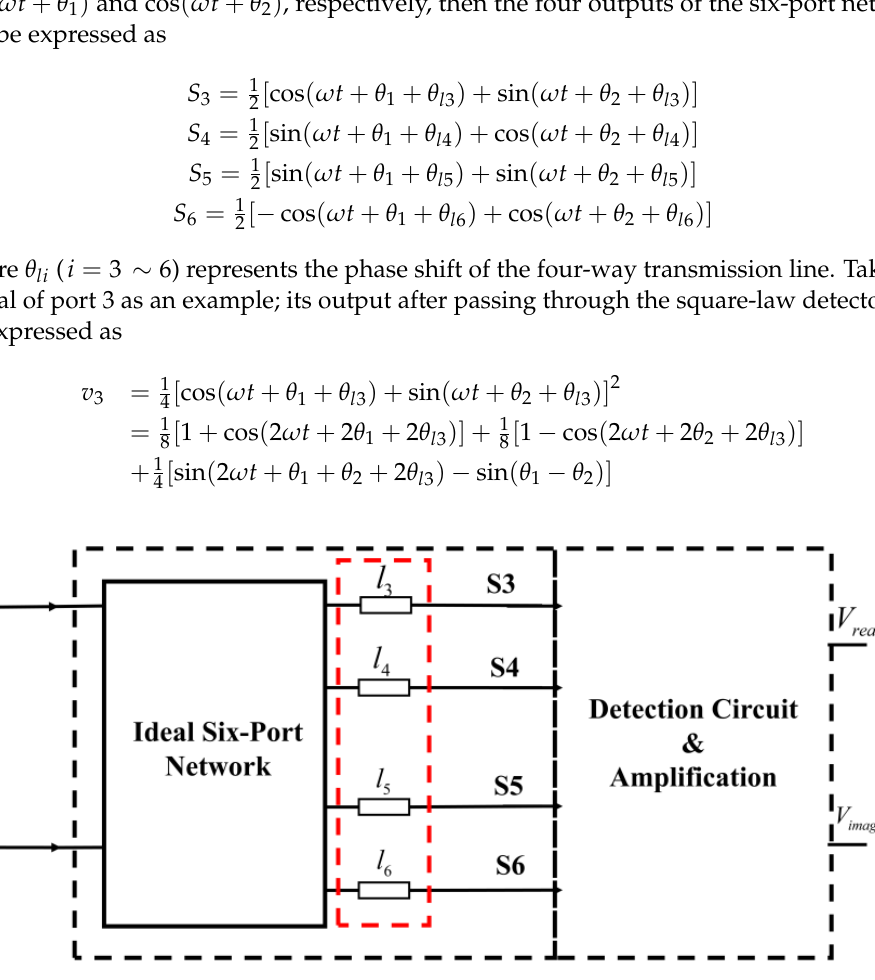
Figure 6. The circuit diagram of the designed correlator based on the integrated six-port chip. Next, we will briefly introduce the basic situation of the six-port chip, then design the square-law detector, and finally complete the integration and implementation of the designed analog correlator. 3.1. Introduction of the Integrated Six-Port Chip The six-port chip that is used in the correlator has been completed in our previous work [33]. The six-port chip is designed and fabricated using the 0.15 um GaAs process, and the size of the final fabricated chip, which is shown in Figure 7, is 5 mm × 2 mm.